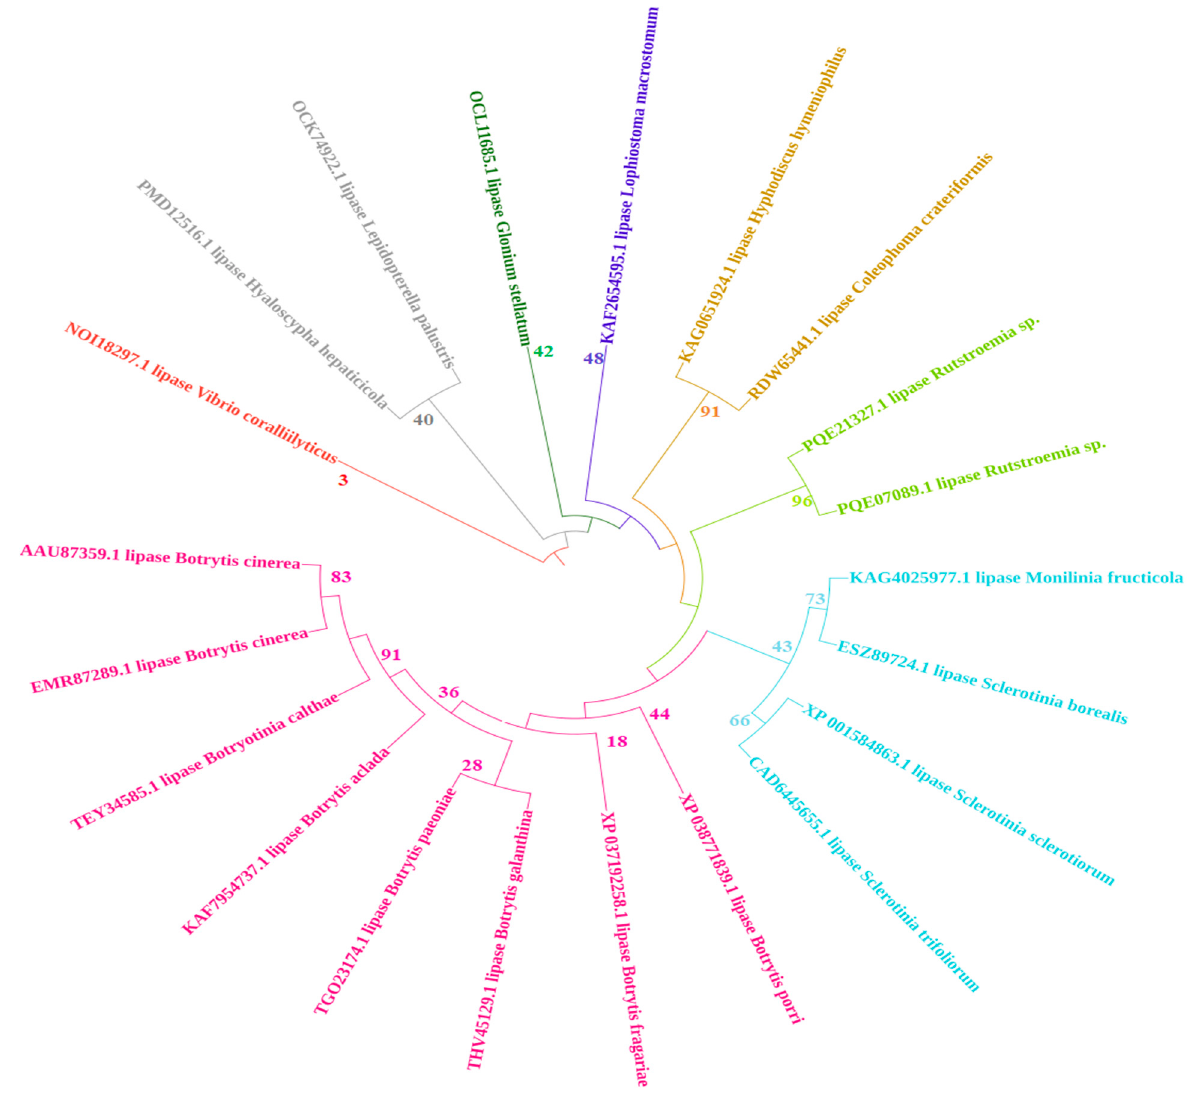
Figure 2. Phylogenetic tree of B. cinerea lipase. Phylogenetic rooted tree of B. cinerea lipase is constructed using maximum likelihood method .